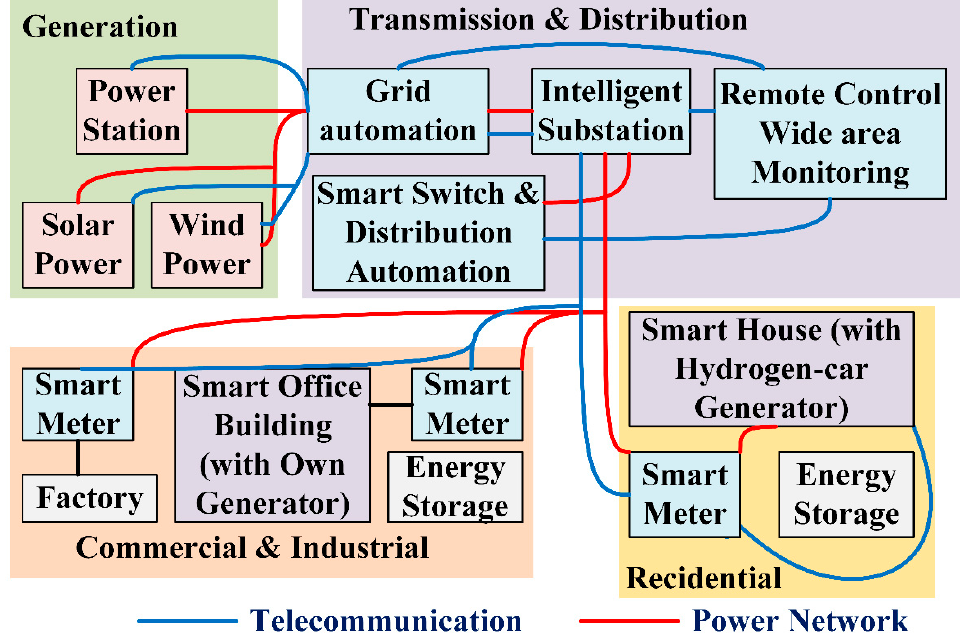
Figure 7. Power and telecommunication network in smart grid. It works as the backbone of SCADA system. It contains wireless radio connection, dial-up lines, ethernet, and IP protocols. Fiber-optic and power line communications are expected to integrate into SG system [63].